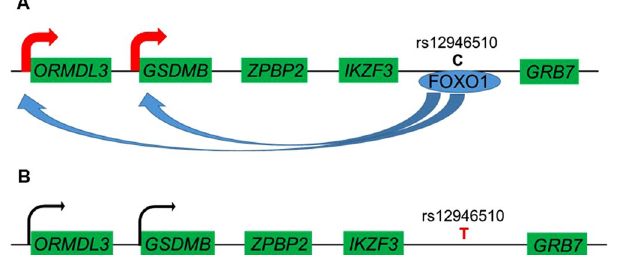
Figure 6. The potential functional effect of the major (C-allele) and PBC susceptibility allele (T-allele) of rs12946510. ( A ) The FOXO1 binding motif is located around the major allele (C-allele) of rs12946510 in the intergenic region between GRB7 and IKZF3 , and probably enhances the expression of GSDMB and ORMDL3 . ( B ) In the PBC susceptibility rs12946510-T allele the binding site for FOXO1 is